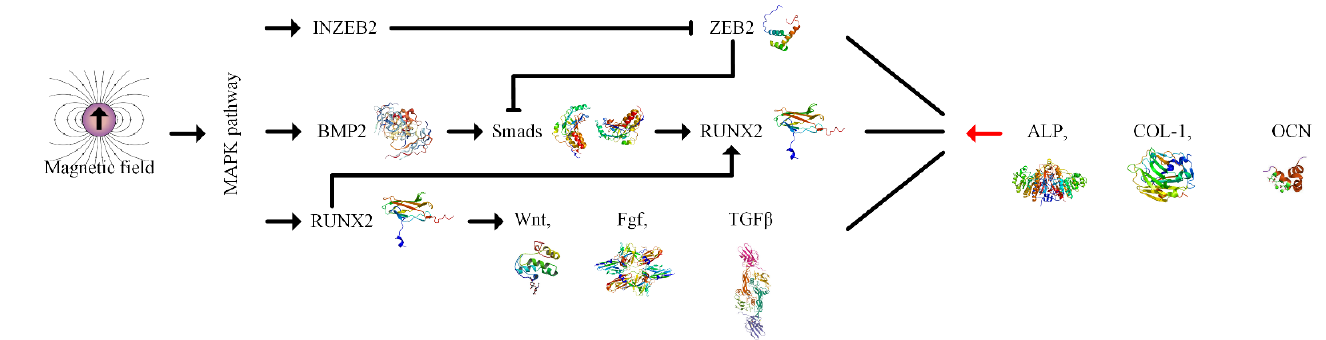
Figure 11. The influence of the magnetic fields of MNPs/SPIONs on the osteogenic differentiation of stem cells in accordance with the mitogen-activated protein kinase (MAPK) pathway.